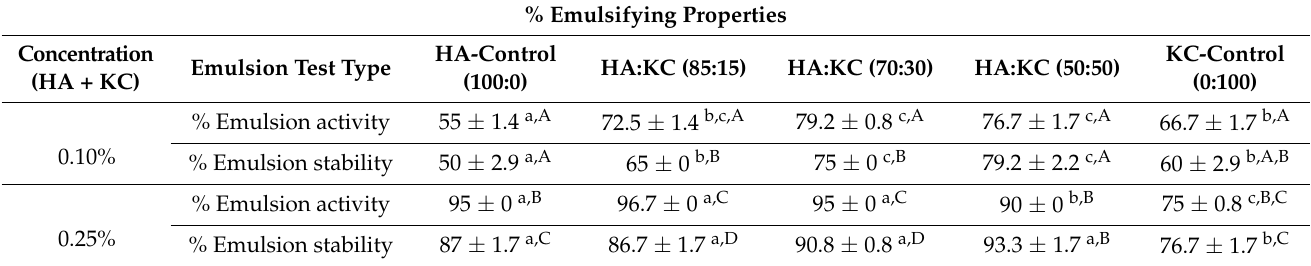
Table 3. Emulsifying properties (emulsifying activity and stability) of skim milk sample treated with different concentrations (0.1 and 0.25% HA + KC) and different ratios of HA + KC blend.